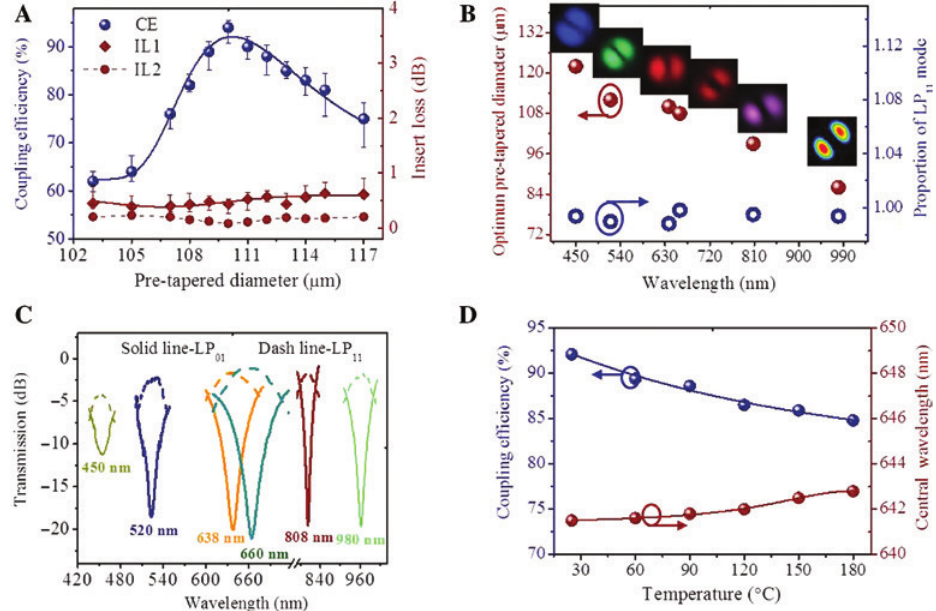
Figure 3: The performance of mode selective couplers (MSCs). (A) Conversion efficiency and insertion loss of 638 nm MSC at different pre-tapered diameters of SMF. (B) Optimum pre-tapered cladding diameters and the proportion of LP mode of visible light MSCs. Inset: experimental LP mode intensity profiles of the all-fiber MSCs at 450, 11 11 520, 638, 660, 808, and 980 nm. (C) Transmission spectra of visible wavelength and 980 nm MSCs. (D) Conversion efficiency and central wavelength of 660 nm MSC heated from 25 ° C to 180 ° C.